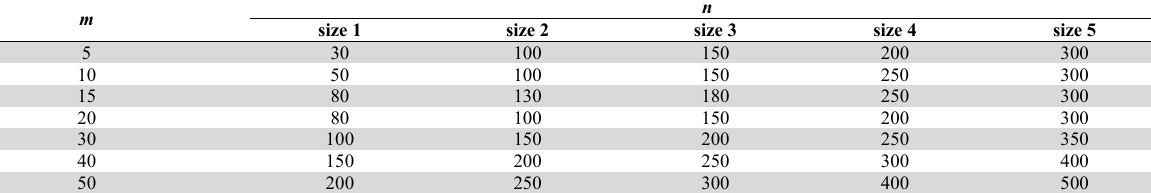
Selected dimensions for the test